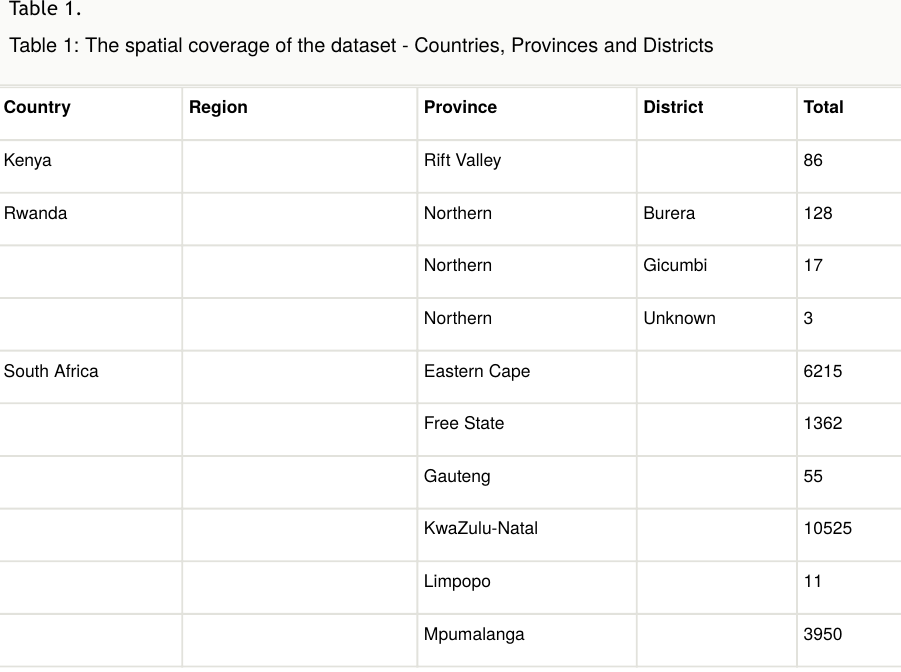
Description: General spatial coverage : The geographic range of the dataset covers fi ve African countries: Kenya, Rwanda, South Africa, Uganda and Zambia (Table 1, Fig. 1). South Africa had the most recorded crane sightings (97.9%; Fig. 2), spread across all 9 provinces. Zambia had the second highest number of recorded crane sightings (0.8%)